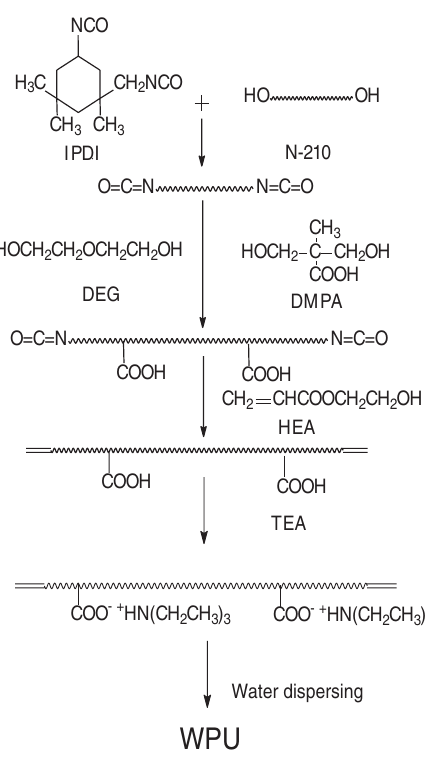
Figure 1: Synthetic route of the